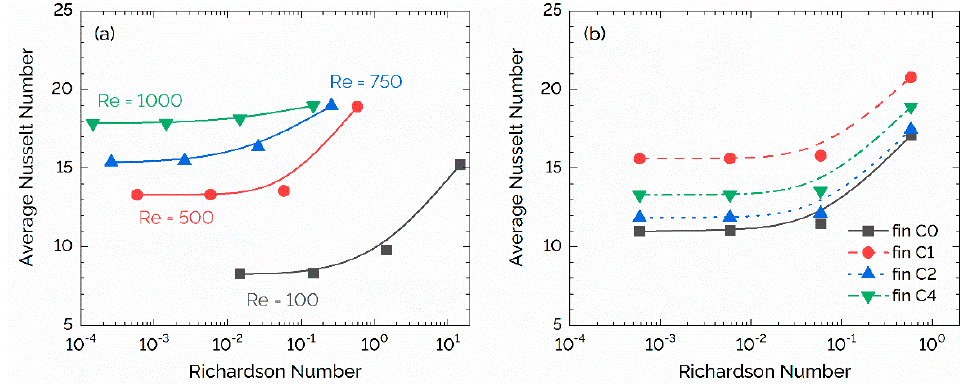
Figure 15. ( a ) Average Nusselt number against Richardson number for the C4 alveolar fin, and ( b ) average Nusselt number against Richardson number for each fin with Re =